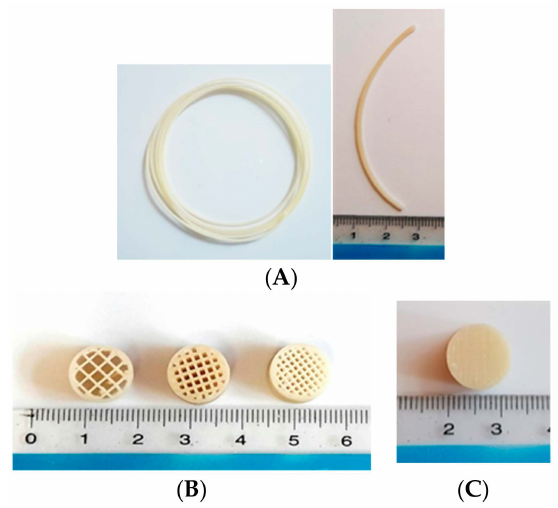
Figure 2. Prepared filaments and tablets. Drug loaded filaments ( A ), printed open system tablets with 25%, 50% and 75% infill left to right ( B ), and printed closed system tablet ( C